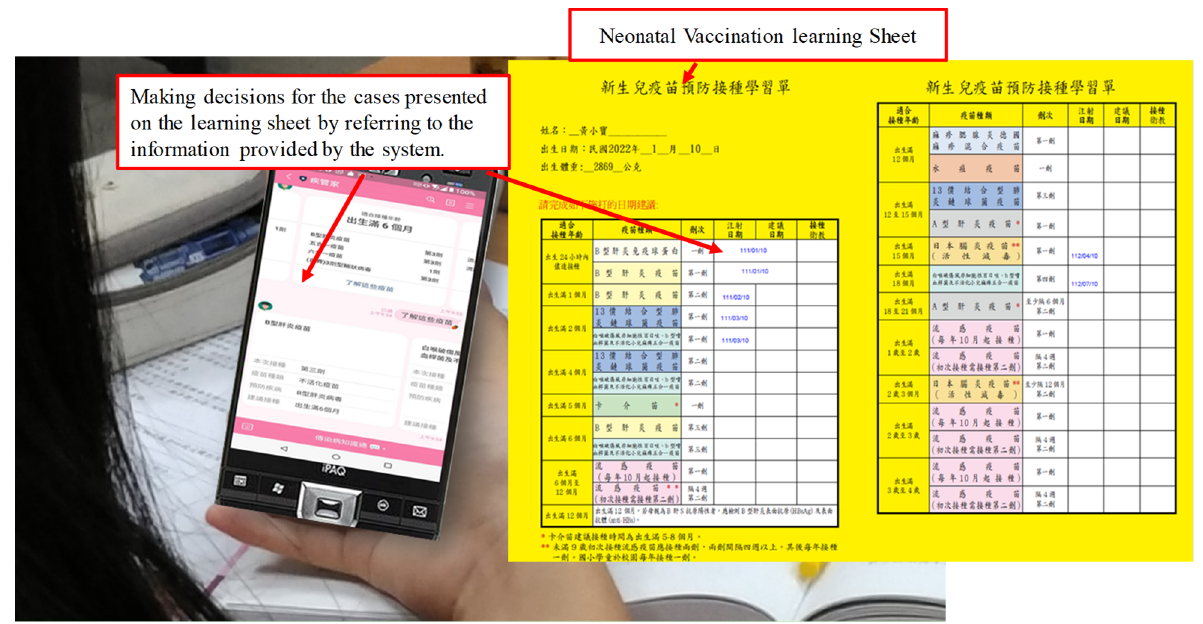
Figure 1. The DRI-based professional training model.